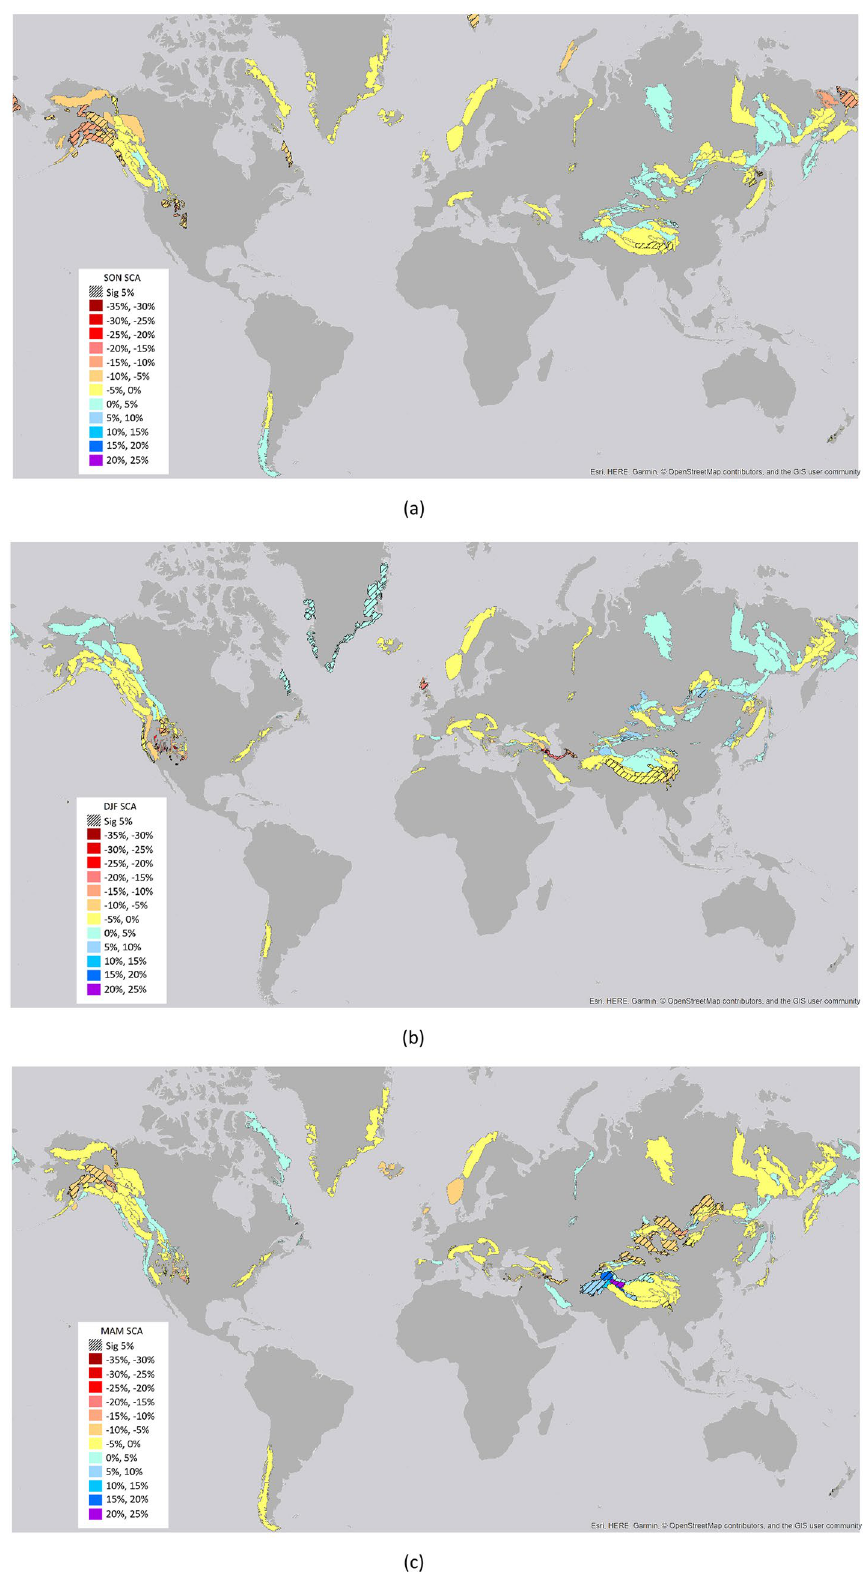
Figure 2. Global trends over 1982–2020 for SCA values in the different seasons: ( a ) September–October– November (SON), ( b ) December–January–February (DJF), ( c ) March–April–May (MAM), ( d ) June–July– August (JJA). The underlined areas show significant trends at 5% level (the maps were created by the author using the software ARCGIS v.10.1, www. esri.